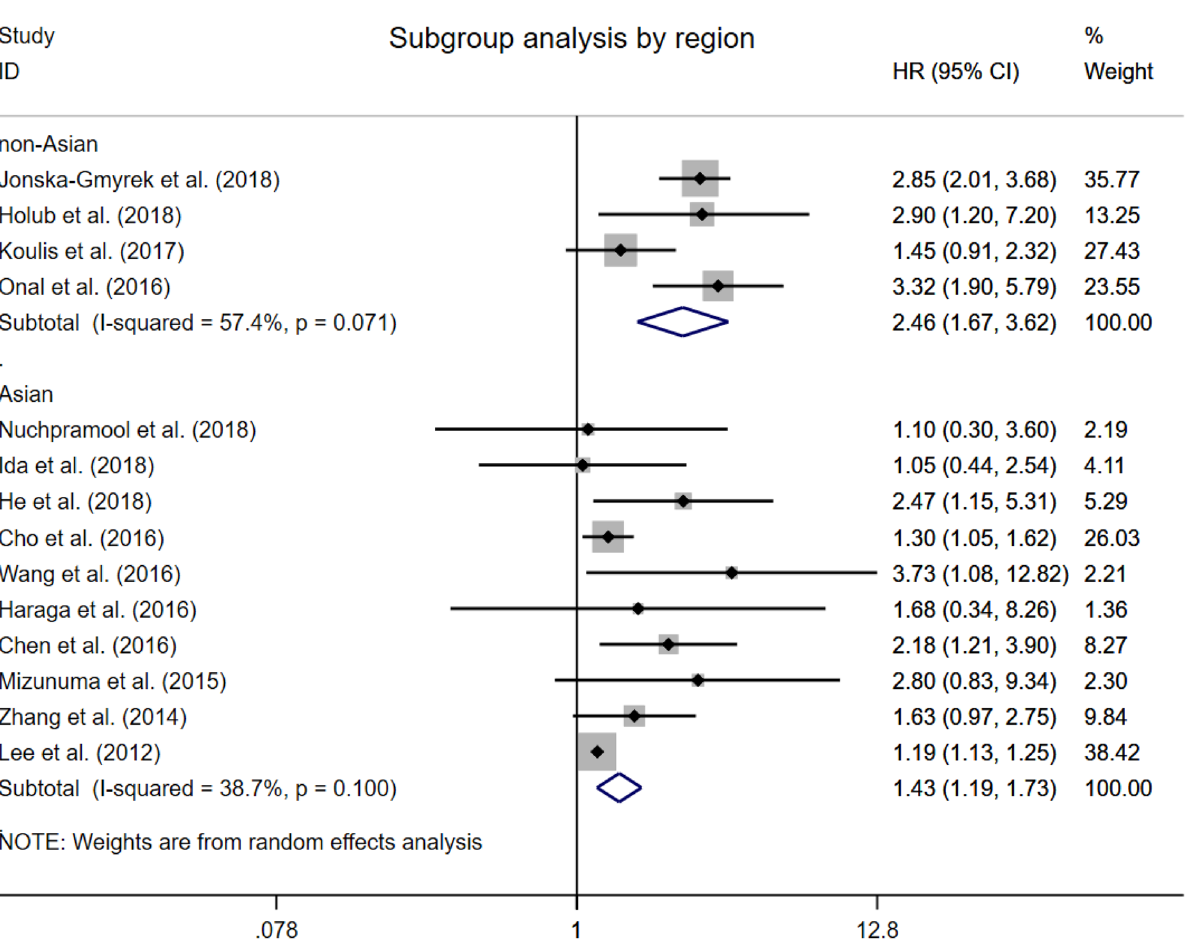
Figure 3. Forest plots showing hazard ratio for overall survival by regions in all studies for neutrophil-to- lymphocyte